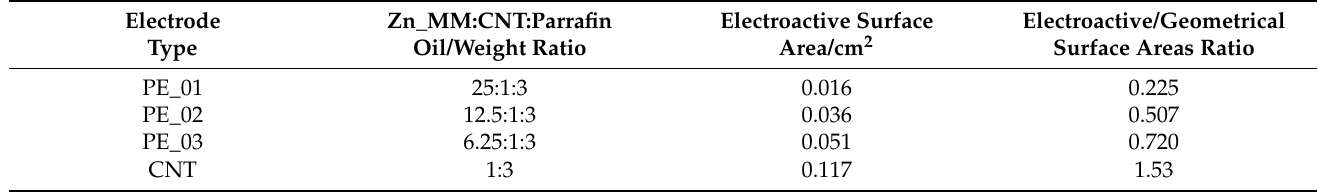
Table 3. Electroactive surface area vs. electrode